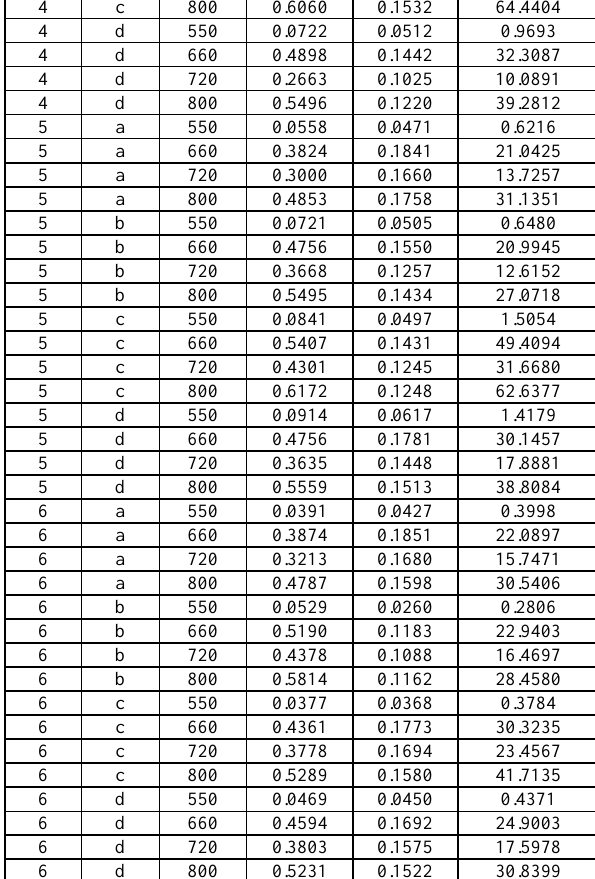
Table 2. Mean, Standard deviation and Sum of square errors of the samples crowns spectral reflectance factor of the pixels along transects. Polynomial adjustment results are presented in Table